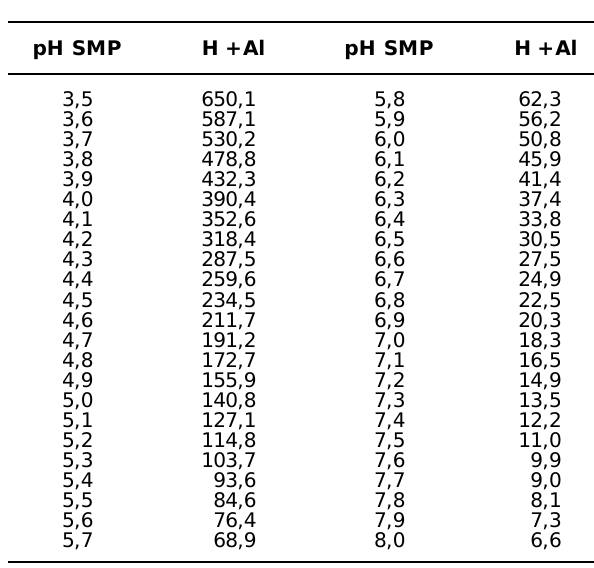
Quadro 1. Conversão de valores de pH SMP para acidez potencial (H + Al), expressa em mmol c dm -3 , para